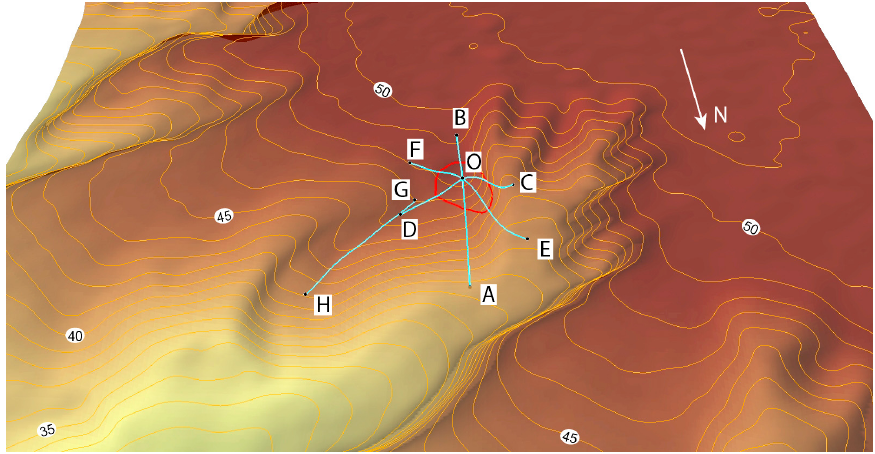
Figure 5. 3D model of the AntGEC location, DEM of 21 August 2013 with the hypsometric profiles position.